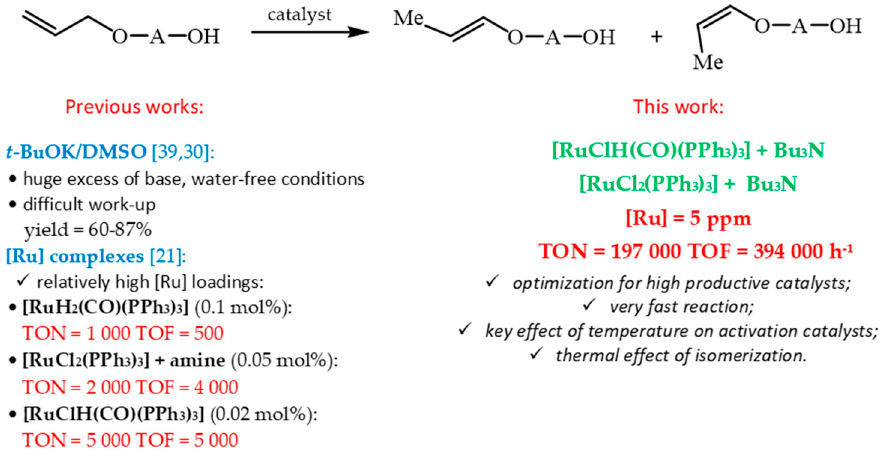
Scheme 3. Concept of high productive synthesis of